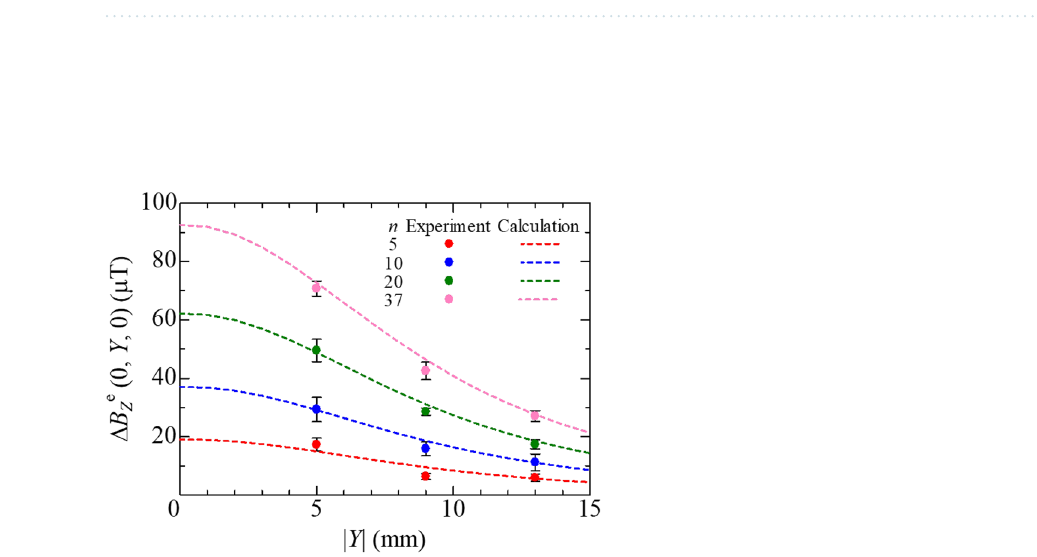
Figure 9. Schematic of modeled Fe–Co fiber and arbitrary point A.